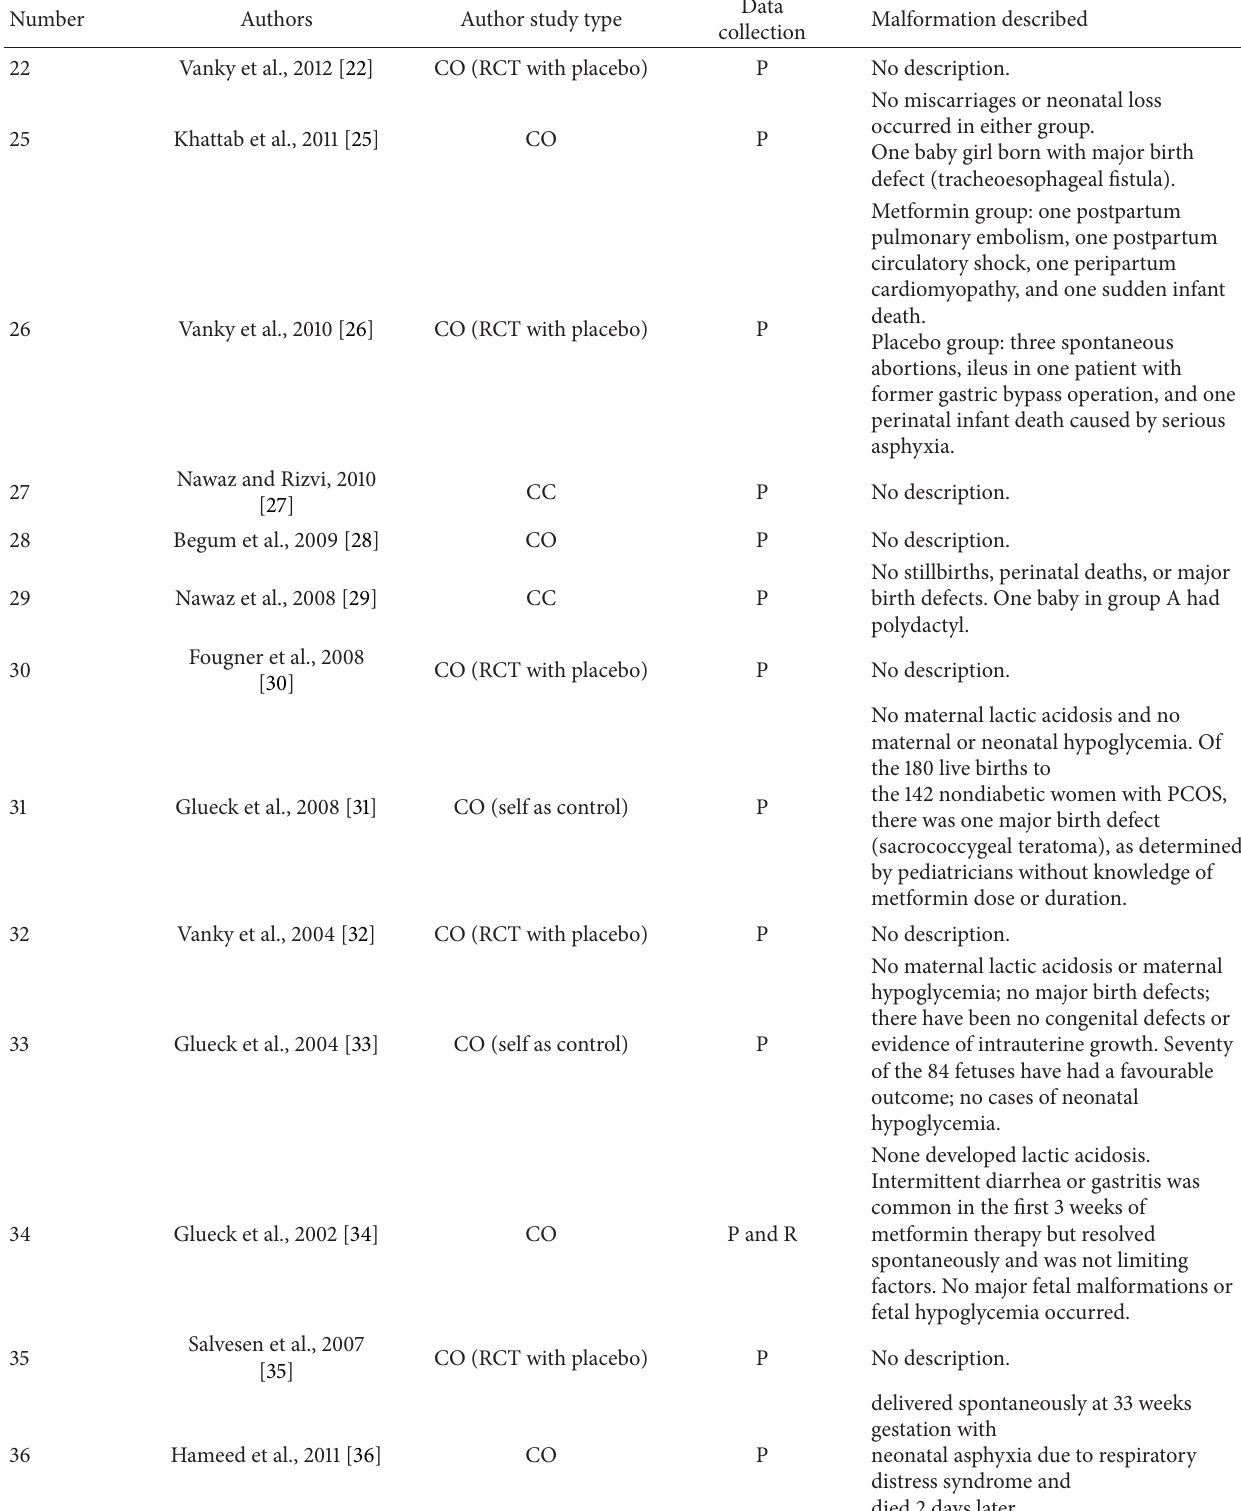
Table 1: Metformin studies included in the